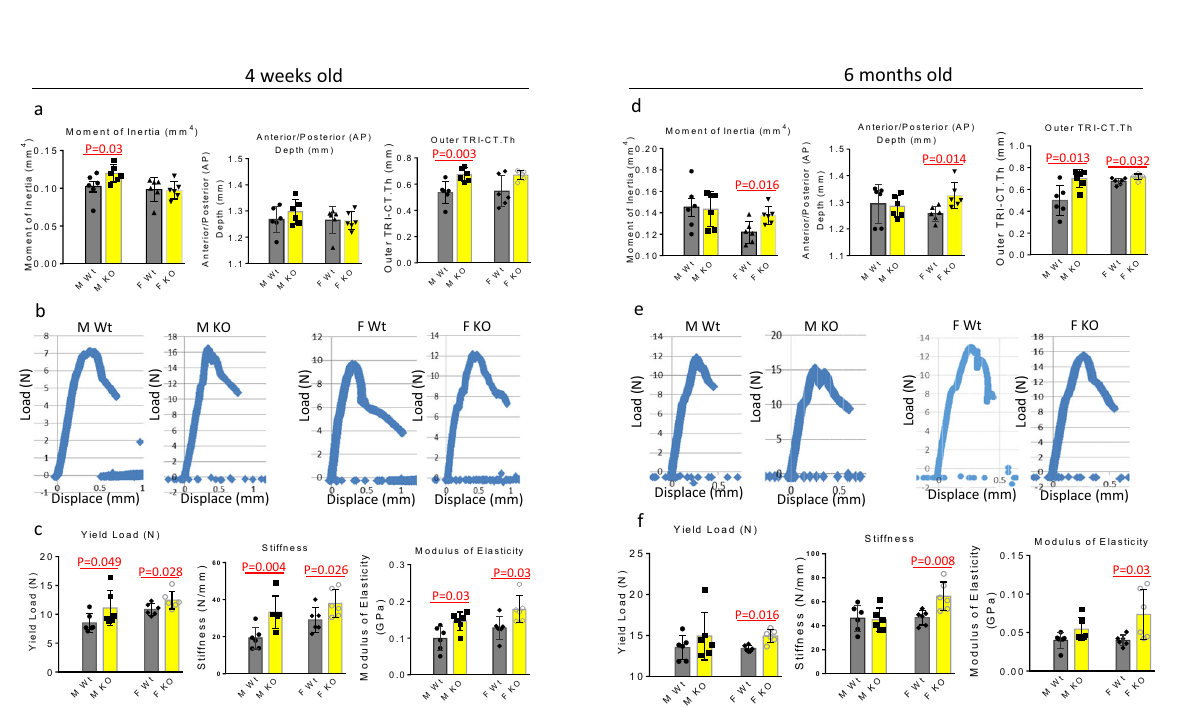
Micro-computed tomography (CT) measurements of trabecular of vertebra bone L5 from 4-weeks-old male and female mice were evaluated using a Skyscan microCT scanner (SkyScan 1272, Bruker. com)at8 μ mpixelsizewithanX-raysourcepowerof60kVand166 µ Aandintegrationtimeof950ms.BV/TV,Percentbonevolume;BS/BV,Bonesurface/volumeratio;BS/TV,Bonesurfacedensity; Tb.N, Trabecular number; Tb.Th, Trabecular thickness; Tb.Sp, Trabecular separation; DA, Degree of anisotropy; TV, Tissue volume; BV, Bone volume. * p <0.05 versus Wt versus GPR109A − / − , n = 6, mean ± SD.